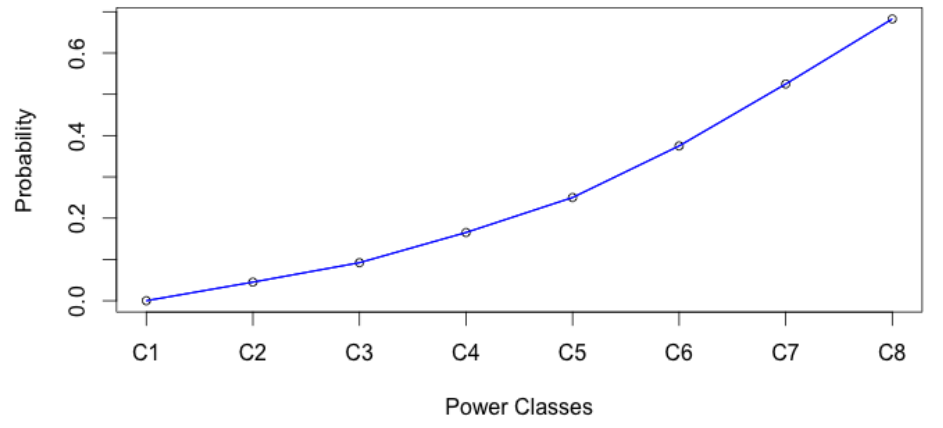
Figure 1. Empirical curve of probability of lower misclassification (PLM): The x -axis shows the power classes obtained by the Fisher – Jenks method and the y -axis shows the probability of the associated lower misclassification.